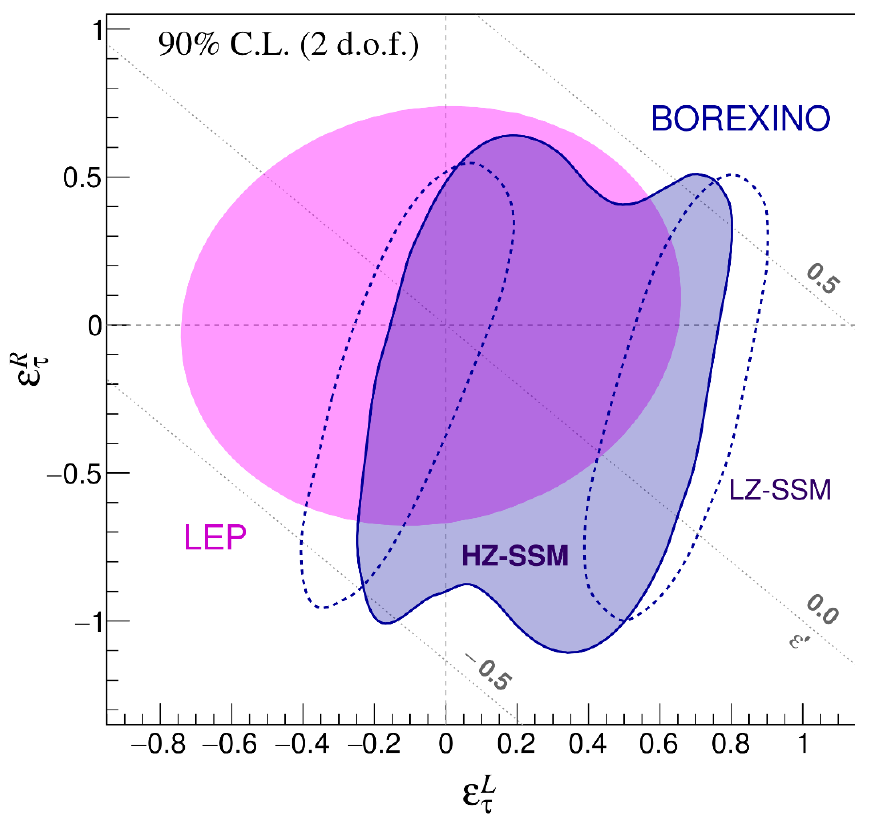
Figure 7 . Allowed region for NSI parameters in " L=R (cid:28) plane obtained in the present work. The parameters " L and " R are (cid:12)xed to zero. Both HZ- ((cid:12)lled dark blue) and LZ- (dashed dark blue) e e SSM’s were assumed. The contour from LEP [55] is provided for comparison. Both contours correspond to 90% C.L. (2 d.o.f.). The dotted gray lines represent the corresponding range of " 0 parameter, relevant for NSI’s at